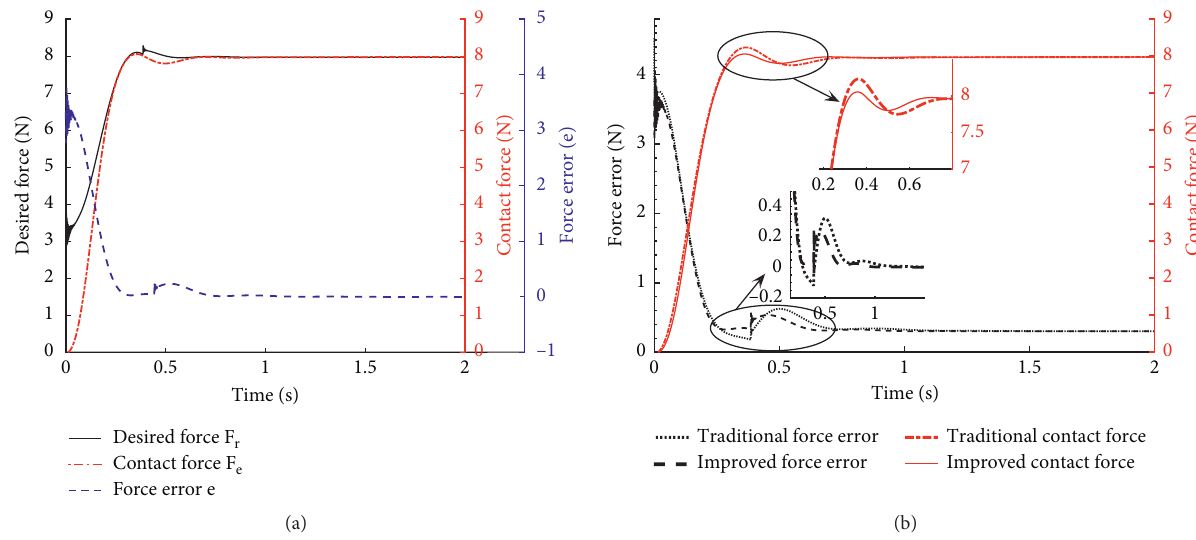
Figure 16: Simulation results of improved impedance control. (a) Curves of desired force, contact force, and force error varying with time. (b) Contact force comparison under two impedance control